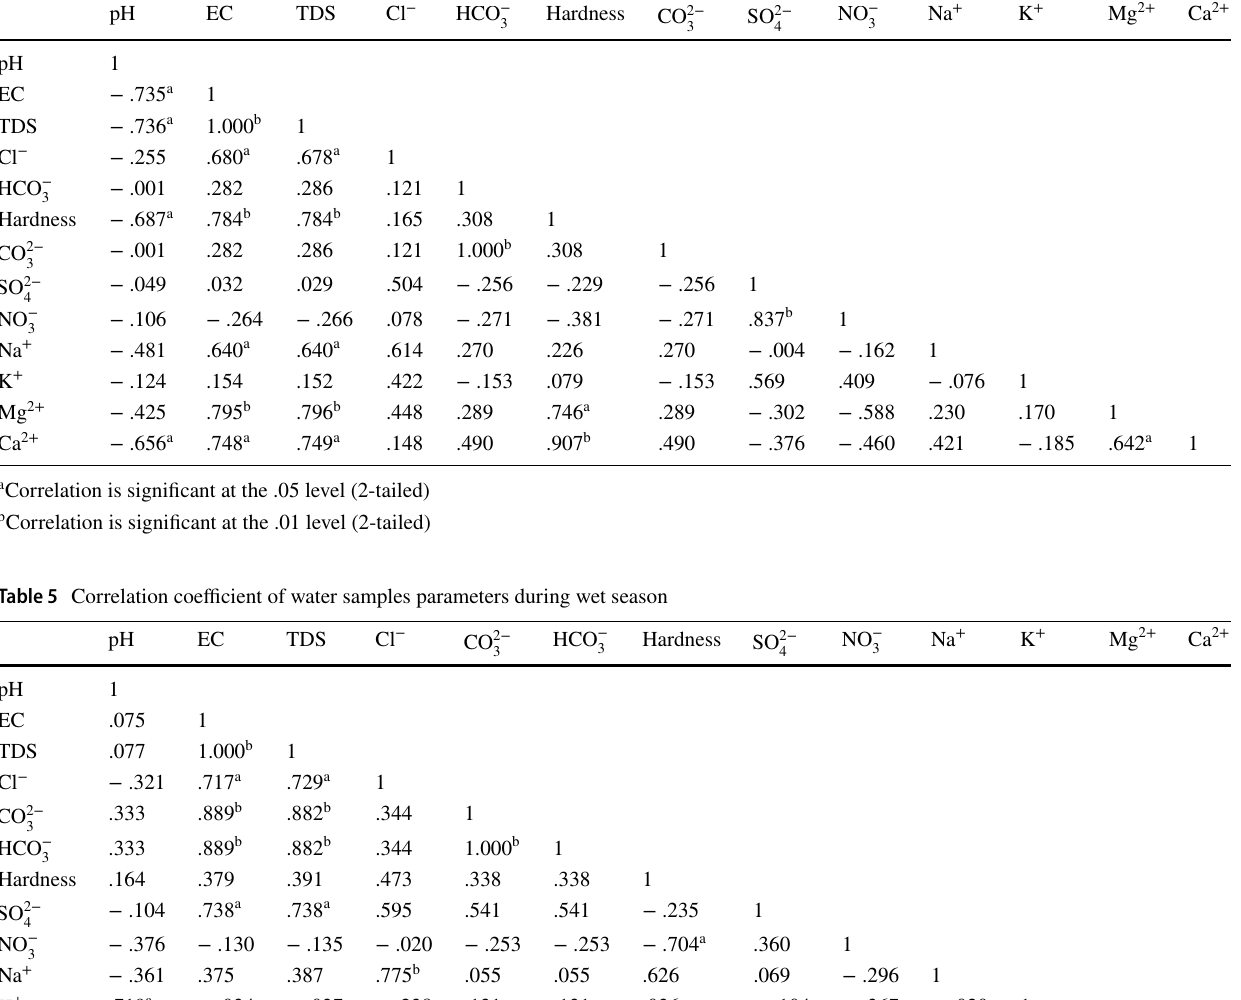
Table 4 Correlation coefficient of Ajakanga water samples parameters during dry season